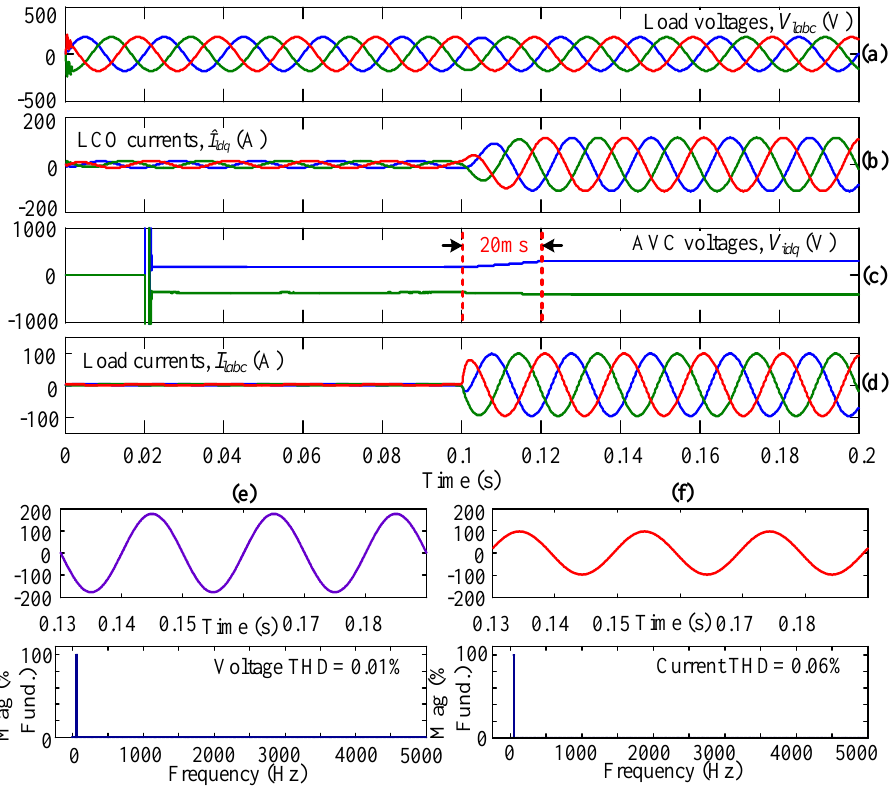
Figure 7. Simulation results for case-II with balanced load condition.